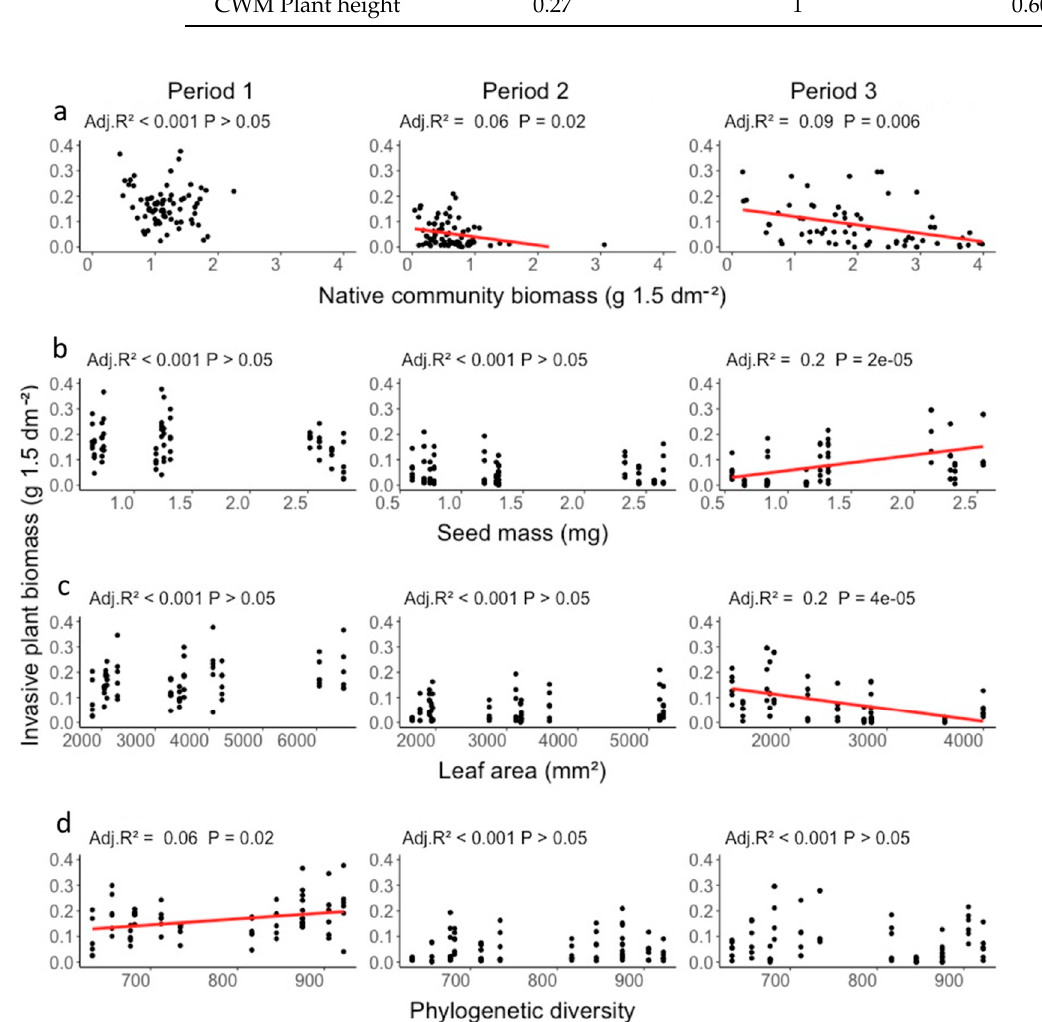
Figure 2. Effects of ( a ) native grassland biomass, ( b ) community-weighted mean seed mass and ( c ) leaf area, and ( d ) phylogenetic diversity on biomass of the invasive native Jacobaea aquatica (averages per week, biomass per tray) in three experimental periods (period 1, 10 weeks; period 2, 15 weeks; period 3, 22 weeks). Overall significant effects of native community biomass ( χ 2 = 16.0, Pr < 0.001), seed mass ( χ 2 = 10.9, df = 1, Pr < 0.001), leaf area ( χ 2 = 4.2, df = 1, Pr = 0.04) and phylogenetic diversity ( χ 2 = 5.3, df = 1, Pr = 0.02) are shown; regression lines were calculated using linear models.